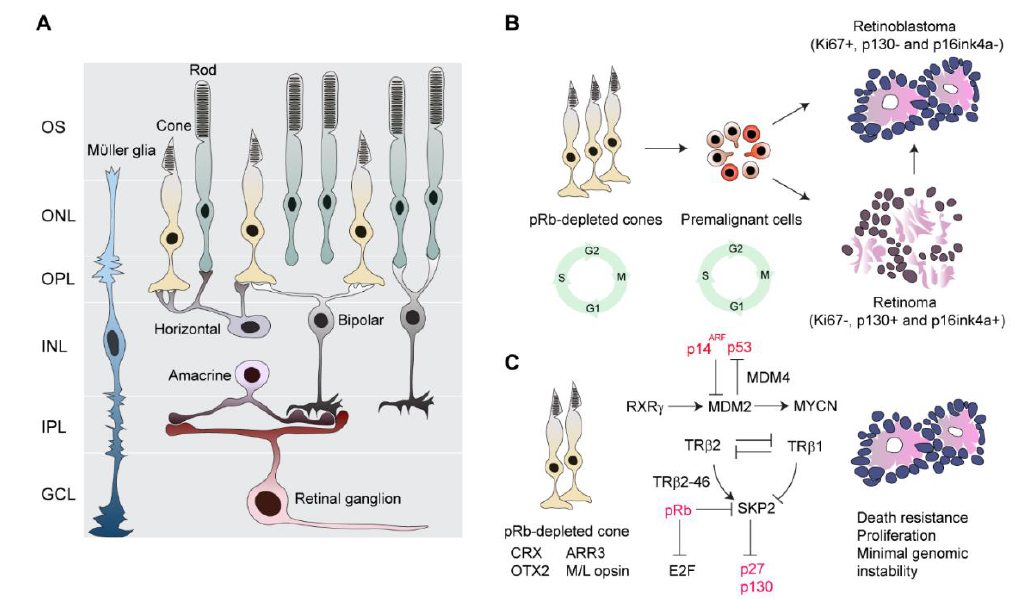
Figure 1. Development of retinoblastoma. ( A ) Major retinal cell types. ( B ) Retinoblastoma protein (pRB)-depleted maturing cone cells re-enter the cell cycles and become neoplastic, while premalignant cells (dark orange), which are vulnerable to cancerous transformation, proliferate highly and develop into retinoblastoma [3,17,26]. However, some other premalignant cells (weak orange) undergo cell cycle arrest and senesce, becoming retinoma that often develop into retinoblastoma [3,17]. ( C ) Cone-associated proteins are present in tumor cells [46,48], while cone circuitry facilitates development of retinoblastoma [17,25,26,46,67–71]. A cone-specific signal circuitry is linked with the pRB pathway through S-phase kinase associated protein 2 (SKP2), whose activity is suppressed through an N-terminal interaction with pRb [72]. SKP2 and oncoprotein Mdm2 (MDM2) are E3 ubiquitin ligase and facilitate degradation of tumor suppressor proteins p27, p130 and p53 [73–75]. See text for details. Red, inactive / decreased proteins; black, synthesized / active proteins. Abbreviations: OS, outer segment; ONL, outer nuclear layer; OPL, outer plexiform layer; INL, inner nuclear layer; IPL, inner nuclear layer; GCL, ganglion cell layer.